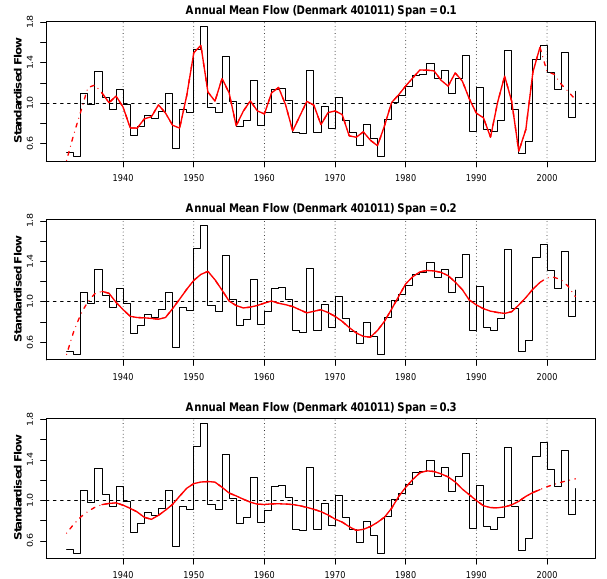
Fig. 1. Illustration of the time series calculated for individual catch- ments. Example of STD time series for annual mean flow for a catchment in Denmark, along with a LOESS STD SM time series in red. Three spans are shown: 0.1 (7.2yr), 0.2 (14.4yr), 0.3 (21.6yr).